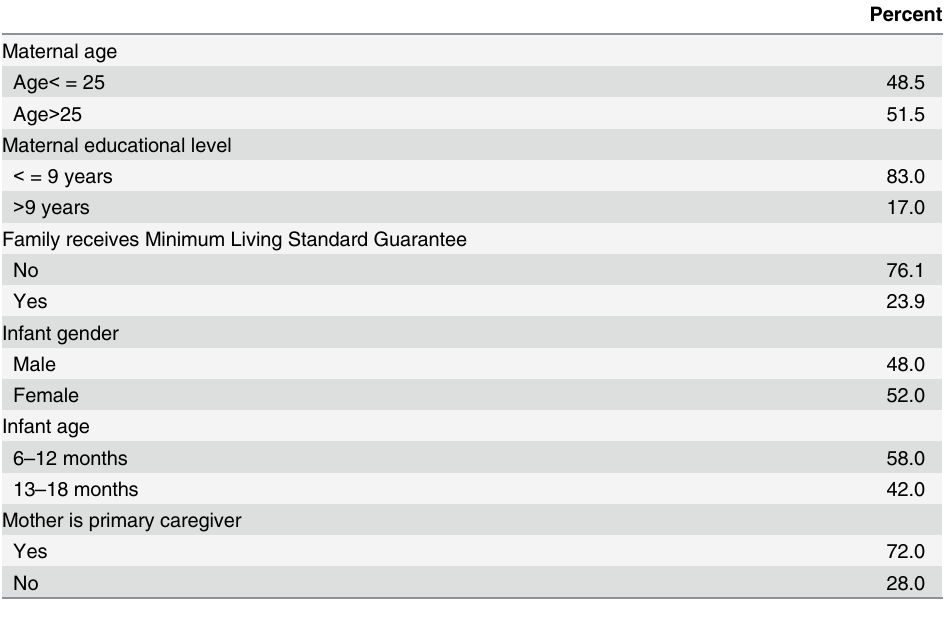
Table 4. Characteristics of individuals from our sample